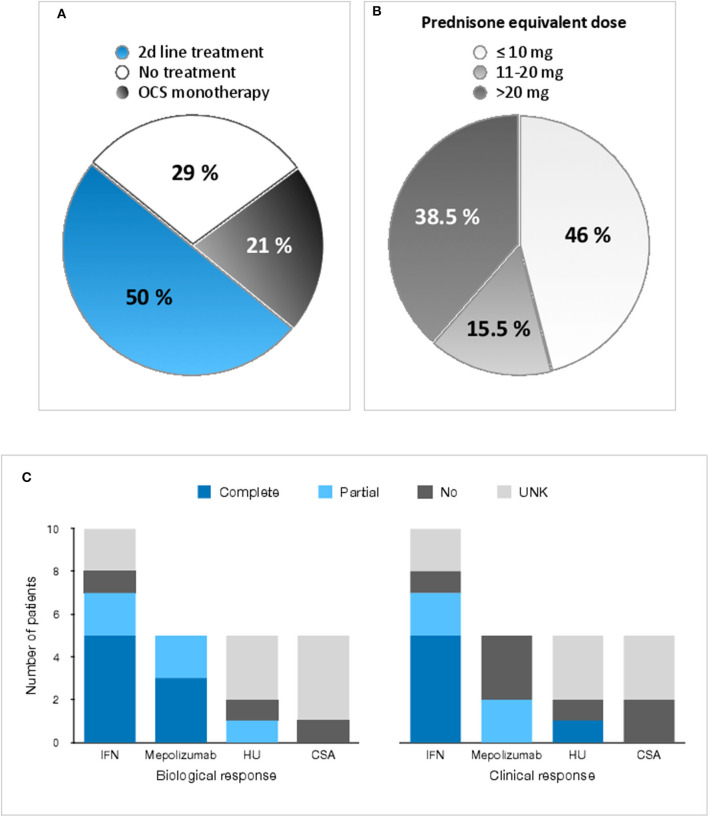
Treatment regimens and responses in patients with CD3−CD4+ T cell associated L-HES. (A) Proportions of patients who required no maintenance treatment (white), prolonged OCS monotherapy (gray), or addition of a second-line agent (blue) to control disease. (B) shows the minimally effective dose of oral CS as monotherapy for a complete response early in disease course in the 13 patients for whom this dose could be determined accurately (one patient was already treated with HU when OCS were initiated, and OCS could not be increased to a dose such that a complete response occurred in two others due to marked intolerance). Proportions of patients who experienced a complete response with a PDN-equivalent dose at 10 mg or less (light gray), 11–20 mg (medium gray), and above 20 mg (dark gray) daily are depicted. (C) shows responses to the most commonly administered second-line agents, separating biological (left) from clinical (right) responses. A partial response is defined as a reduction of eosinophil counts by at least 50% with treatment (biological) and persistent but improved symptoms (clinical). A complete response is defined as normalization of blood eosinophil counts (biological) and resolution of HES-related symptoms (clinical). CSA cyclosporin A, HU hydroxyurea, IFN interferon, UNK unknown. See Supplementary Table 5 for individual data.